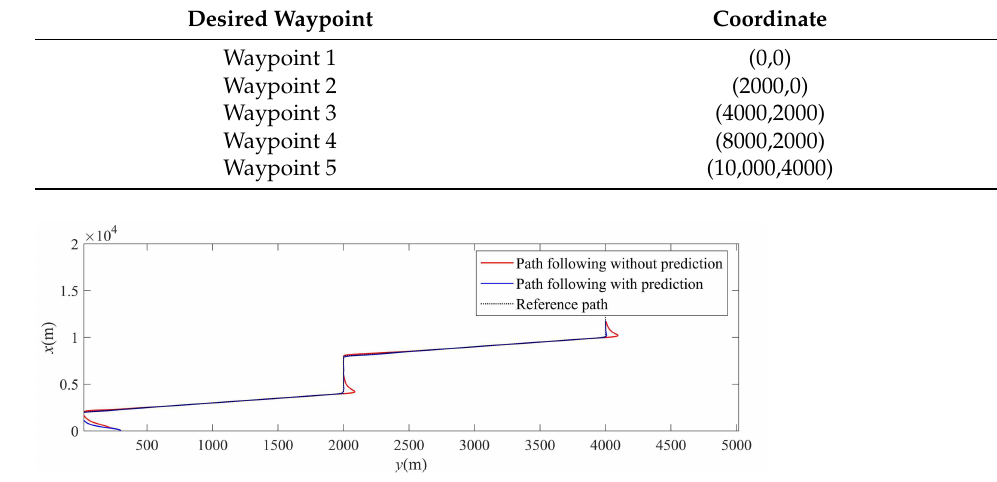
Figure 3. Simulation comparison of ship path following with and without position prediction.